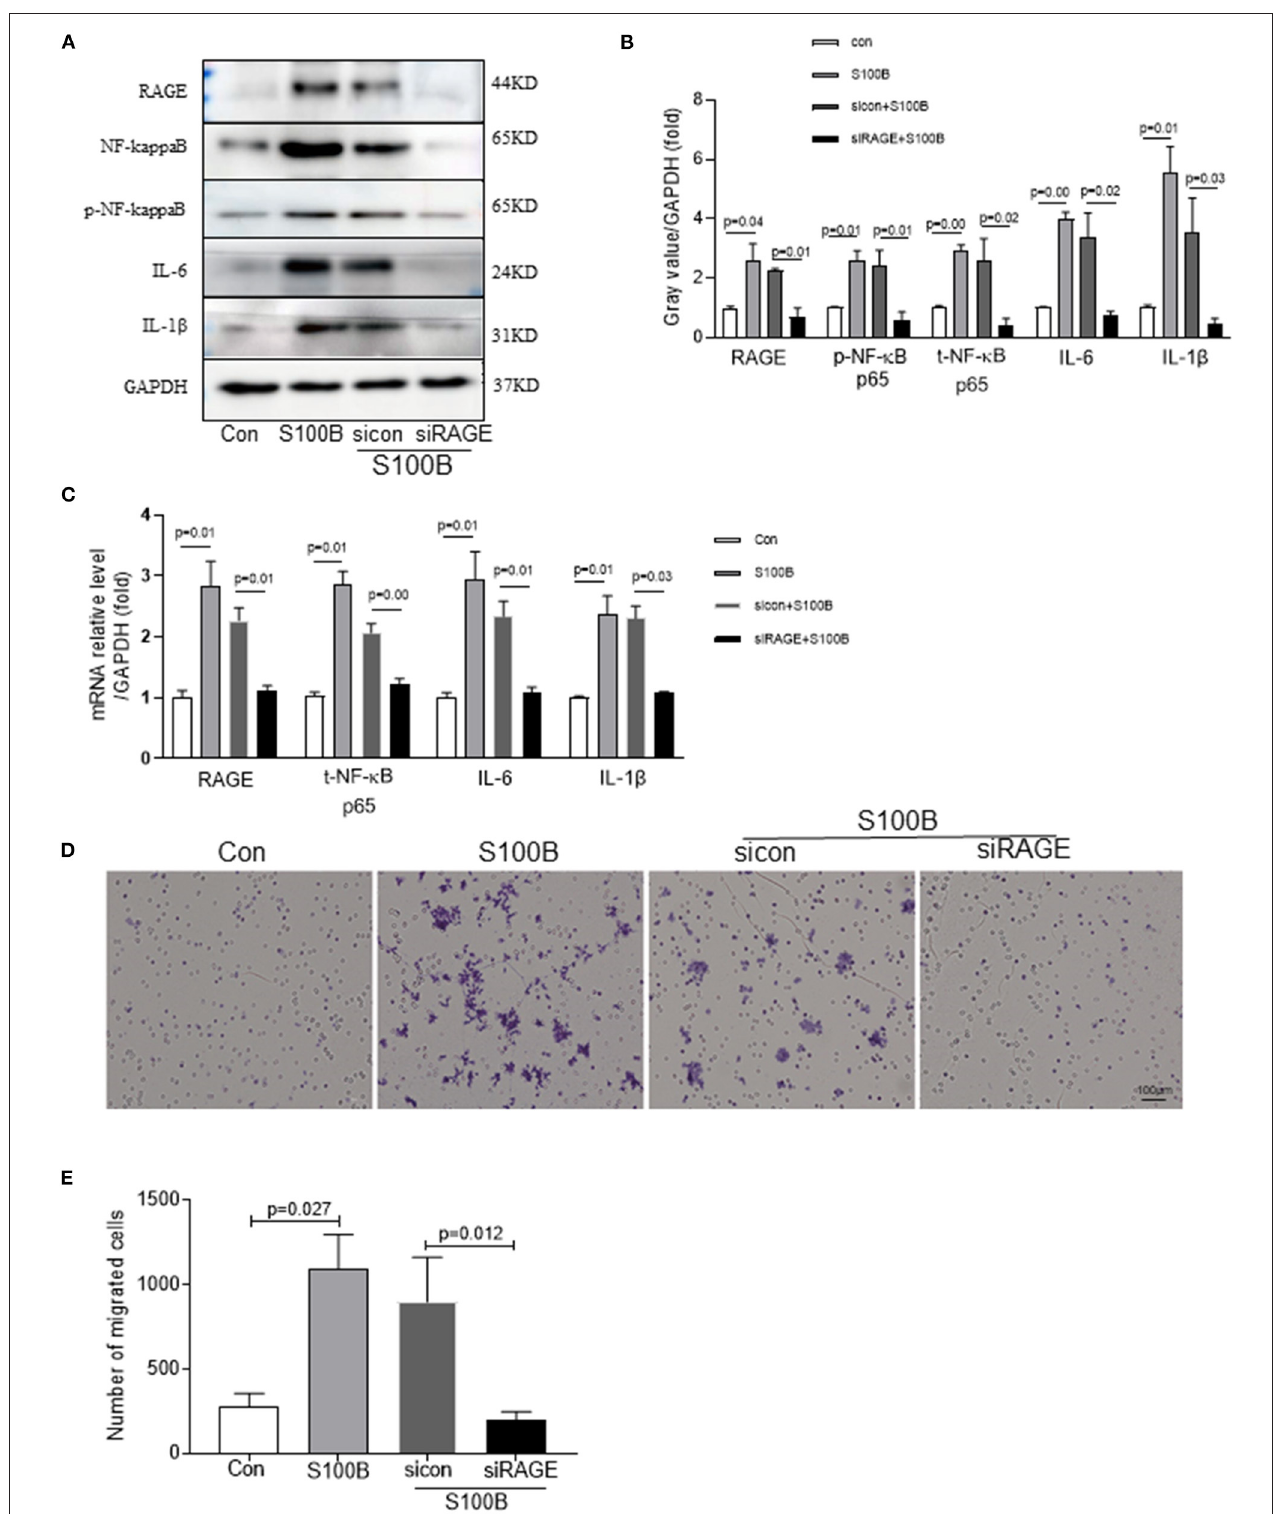
FIGURE 5 | Effect of S100B and S100B receptor knockdown influencing on neutrophils migration through the RAGE–NF κ B–IL1 β /IL6 signaling pathway. (A,B) Western blot analysis of RAGE–NF κ B–IL1 β /IL6 expression in neutrophils with S100B protein, sicontrol and siRAGE (S100B receptor). (C) Quantitative real-time